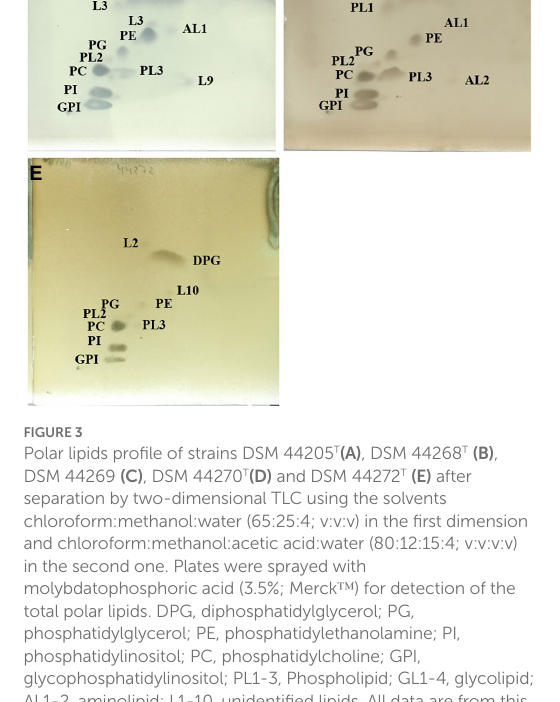
total polar lipids. DPG, diphosphatidylglycerol; PG, phosphatidylglycerol; PE, phosphatidylethanolamine; PI, phosphatidylinositol; PC, phosphatidylcholine; GPI, glycophosphatidylinositol; PL1-3, Phospholipid; GL1-4,